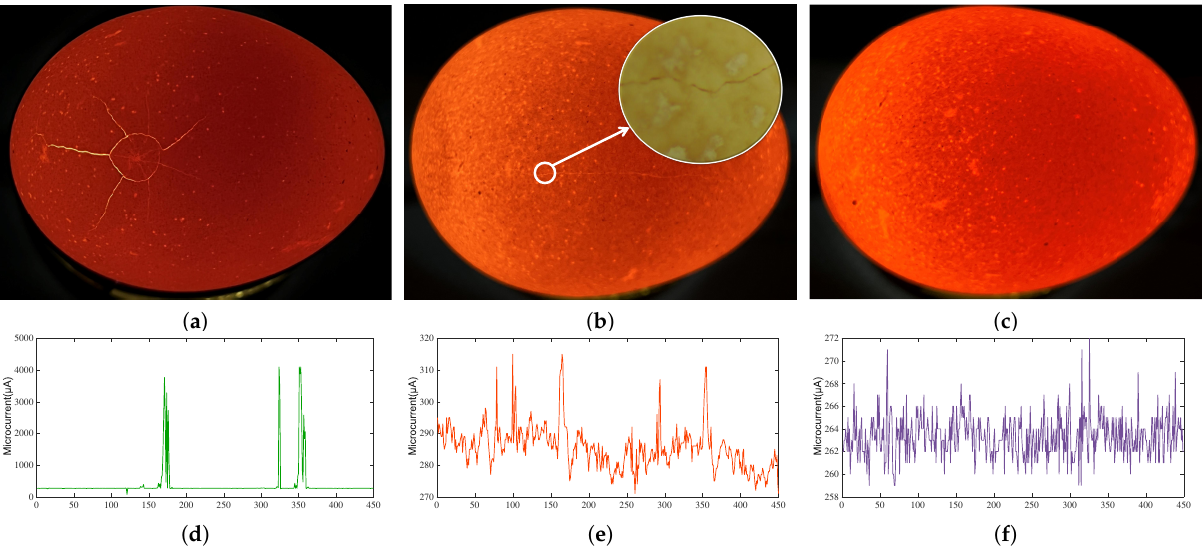
Figure 3. Comparison of current signal changes between cracked and intact eggs, where the abscissa is the sampling point, and the ordinate is the microcurrent. ( a ) A cracked egg sample. ( b ) An indistinguishable cracked egg sample. ( c ) An intact egg sample. ( d ) Micro-current signal of sample ( a ). ( e ) Micro-current signal of sample ( b ). ( f ) Micro-current signal of sample ( c